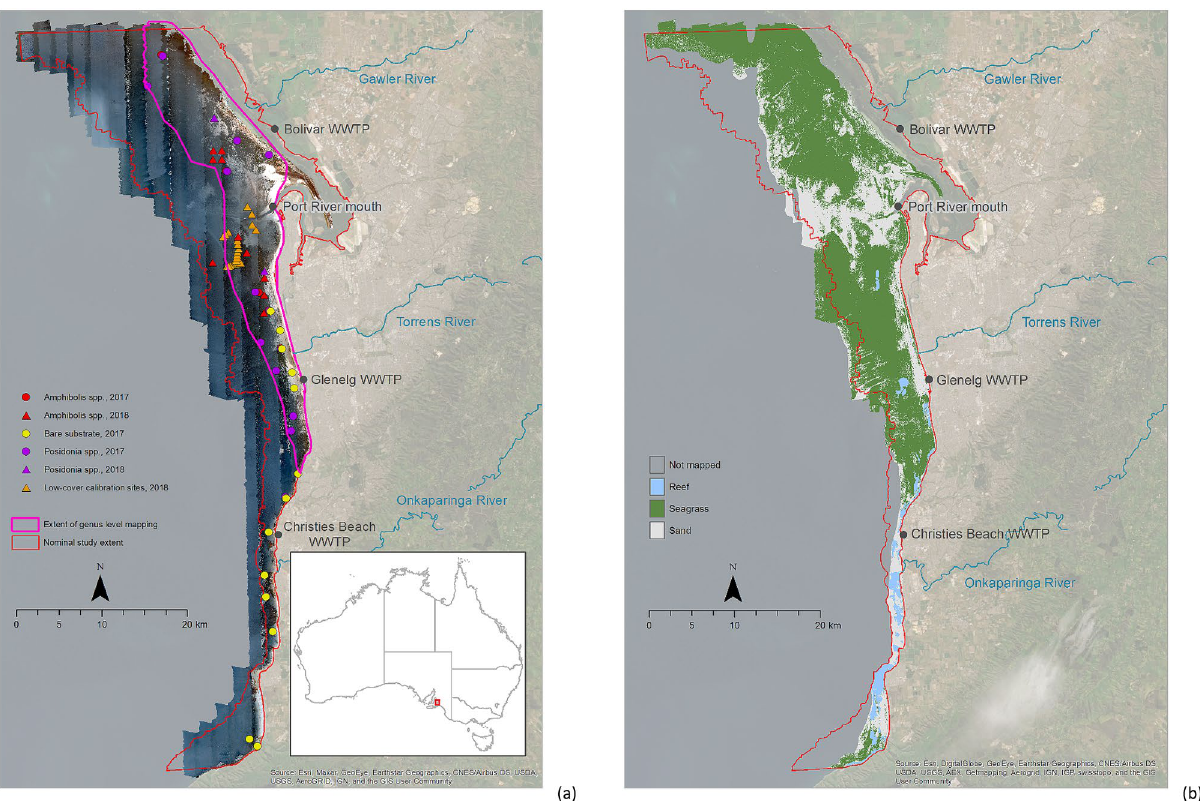
Figure 1. Sunglint corrected, pseudo true-colour image composite of the 2018 hyperspectral imagery ( a ), and benthic cover classification of this imagery ( b ). On the left panel, the nominal study area is outlined in red, and the extent of genus classification (Fig. 3) in purple. Field locations of large patches of homogeneous Amphibolis , Posidonia and sand cover used for accuracy assessment are differentiated by year of record (circle = 2017, triangle = 2018). Location of sites further investigated in 2018 to clarify suspected low cover are also presented. Map created in ESRI ArcGIS 10.7; terrestrial ESRI Basemap World Imagery (https:// www. esri. com/ en- us/ arcgis/ produ cts/ arcgis- enter prise).